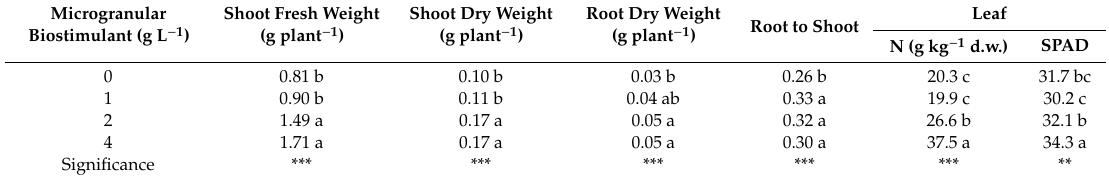
Table 2. E ff ect of biostimulant treatments on dry weight of shoots and roots, root to shoot ratio and nitrogen content, and Soil-Plant Analysis Development (SPAD) index of leaves in tomato transplants (Experiment